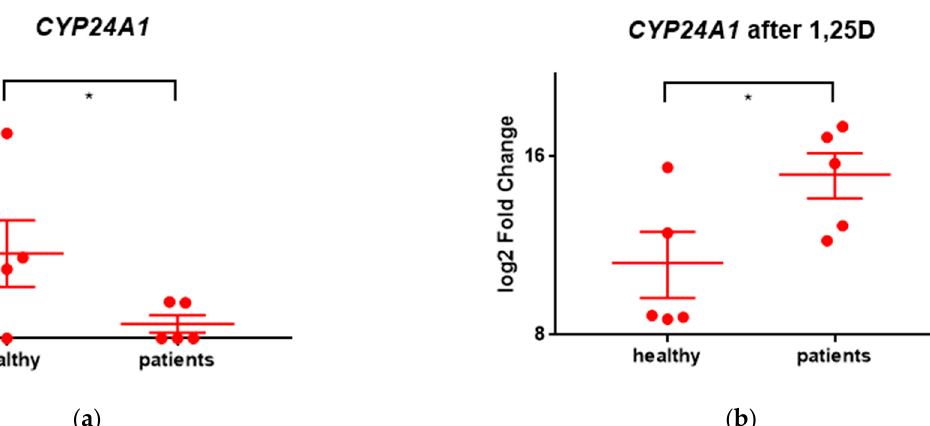
Figure 2. Expression of CYP24A1 in leukocytes from all individuals. Leukocytes from healthy volunteers and blasts from patients were ex vivo exposed to a vehicle or 10 nM 1,25D for 96 h. Then the mRNA was isolated, transcribed to cDNA and sequenced. The background expression ( a ) and the change in expression of CYP24A1 between 1,25D-treated sample in comparison to vehicle-treated sample ( b ) were presented as a dot for everyone. The graph presents means ± SEM and the values obtained for everyone. Values that differ significantly between patients and healthy people are marked with whiskers and asterisks.